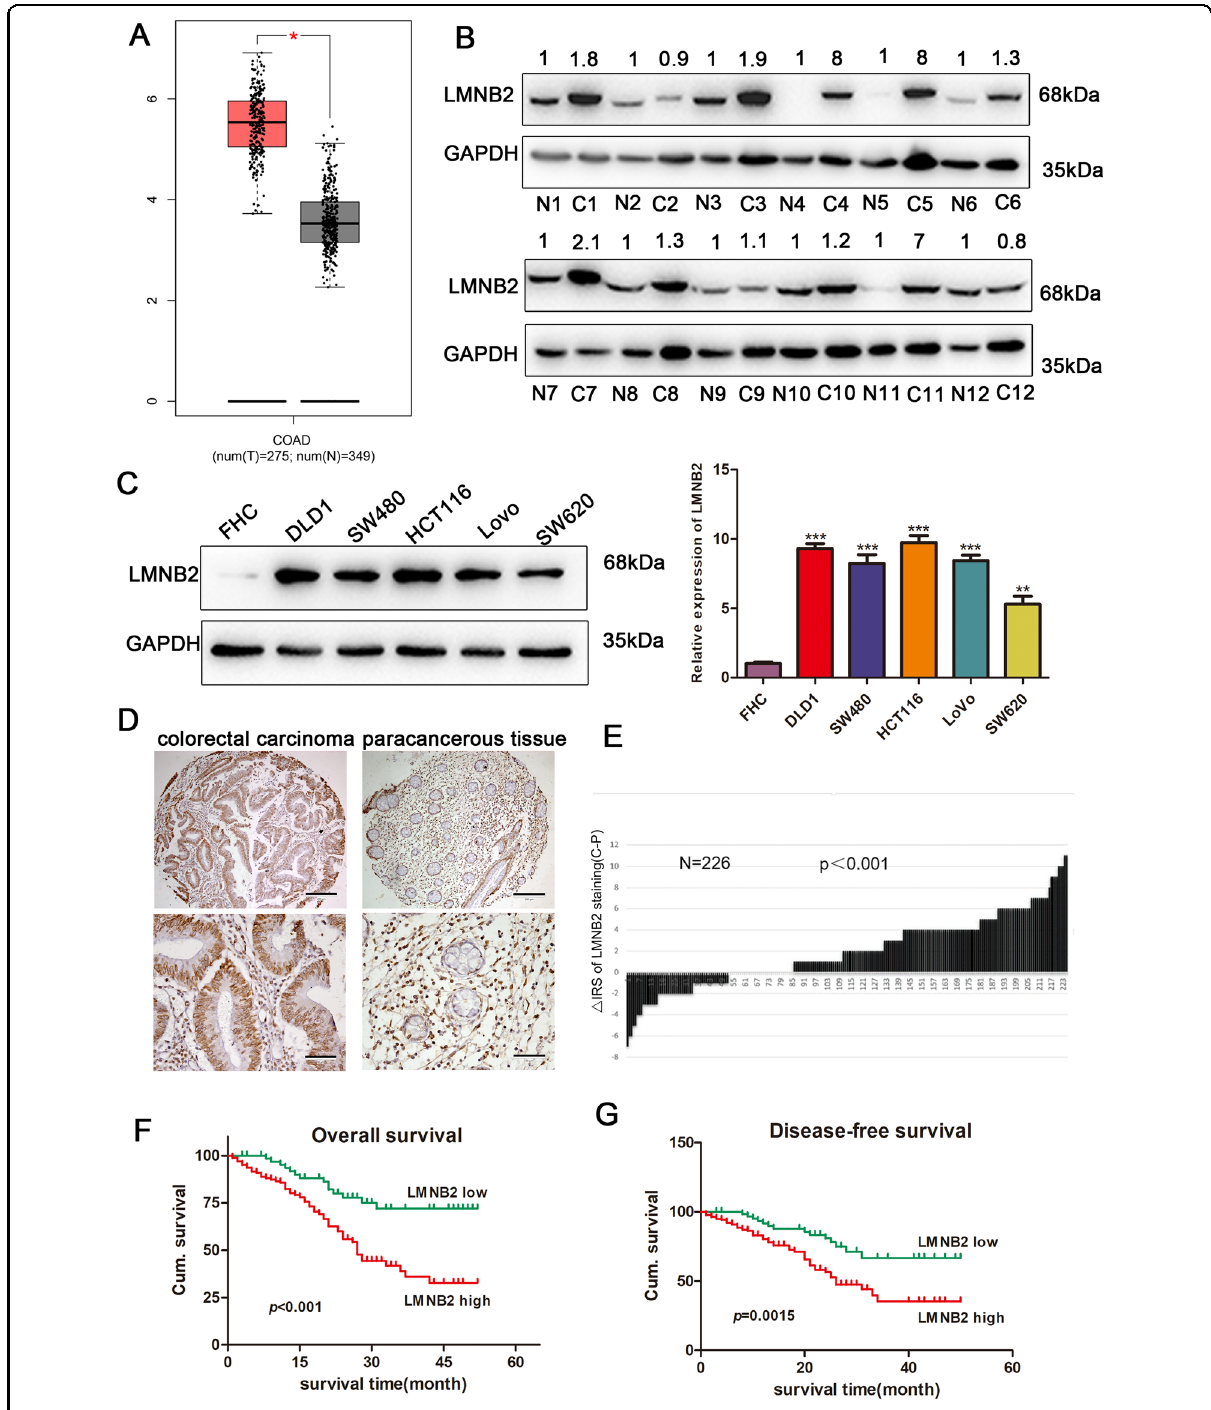
Fig. 1 Expression of LMNB2 is upregulated in CRC and negatively associated with overall and disease-free survival in CRC. A The GEPIA database shows that LMNB2 is highly expressed in colorectal cancer tissues. B Detection of LMNB2 protein levels in 12 cancer tissues and paired normal colon tissues by western blotting. C The expression level of LMNB2 was detected by western blotting in fi ve CRC cell lines and a normal colon epithelial cell line (FHC). D LMNB2 immunohistochemical staining shows TMA. Note: upper screen, the magni fi cation is ×100; lower screen, the magni fi cation is ×400. E Distribution of LMNB2 staining intensity difference between colorectal cancer tissue and paired adjacent tissues. Note: N is the paired adjacent non- cancerous tissue. The expression level of LMNB2 in colorectal cancer tissues was signi fi cantly higher than that in the corresponding adjacent tissues (paired Wilcoxon ’ s test, P <0.001). F High expression of LMNB2 is associated with poorer overall cumulative survival of patients with colorectal cancer ( P <0.001, log- rank test). G High expression of LMNB2 is associated with poor disease-free cumulative survival in patients with colorectal cancer ( P <0.001, log-rank